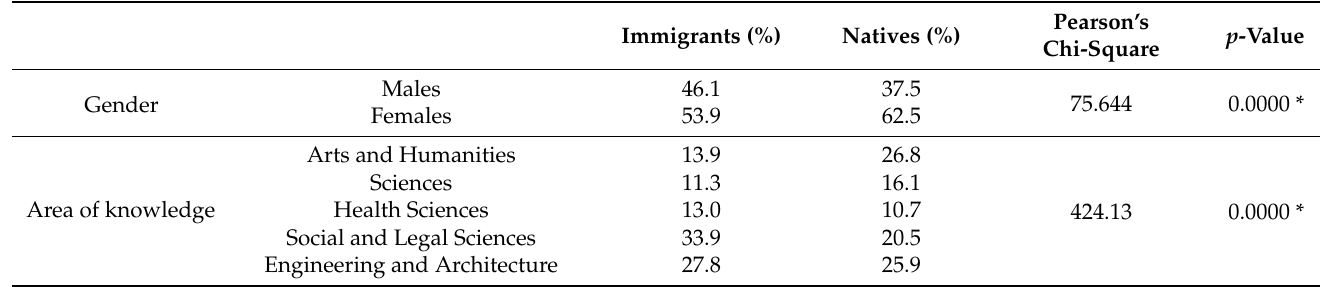
Table 2. Distribution of the participants by gender and area of knowledge, differentiating by digital generation (in percentages) and statistics of the Pearson independence